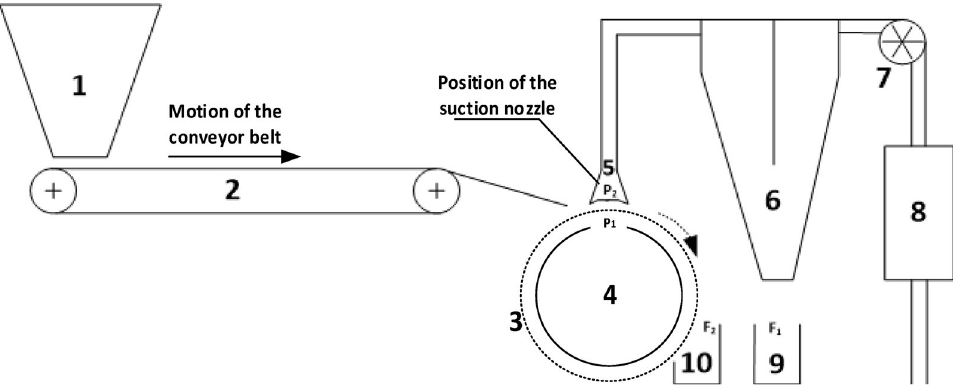
Fig. 1 Outline of installation for the dry separation process: 1—loading hopper with mounted scraper; 2—conveyor belt; 3—perforated rotating cylinder; 4—auxiliary fan and directional nozzle; 5—suction nozzle; 6—separator; 7—main suction fan; 8—dust collector; 9 and 10—reservoirs for grains